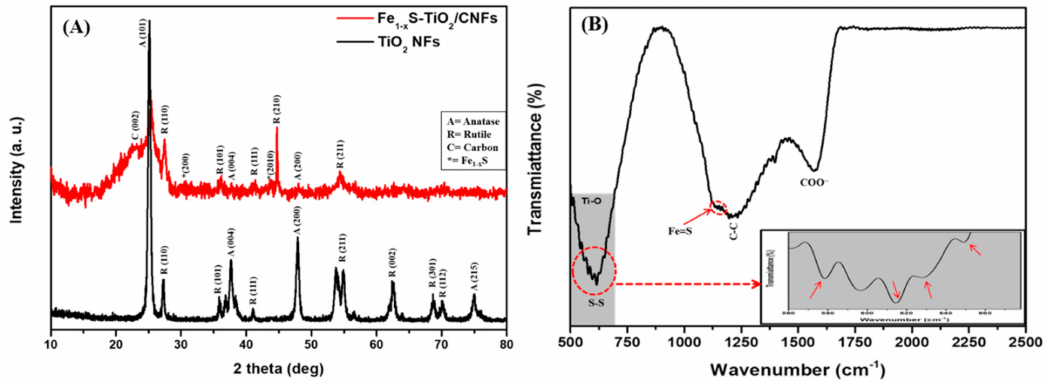
Figure 3. XRD spectra of Fe 1 − x S-TiO 2 / CNFs composite as compared to TiO 2 NFs ( A ) and FTIR spectra of the Fe 1 − x S-TiO 2 / CNFs composite ( B